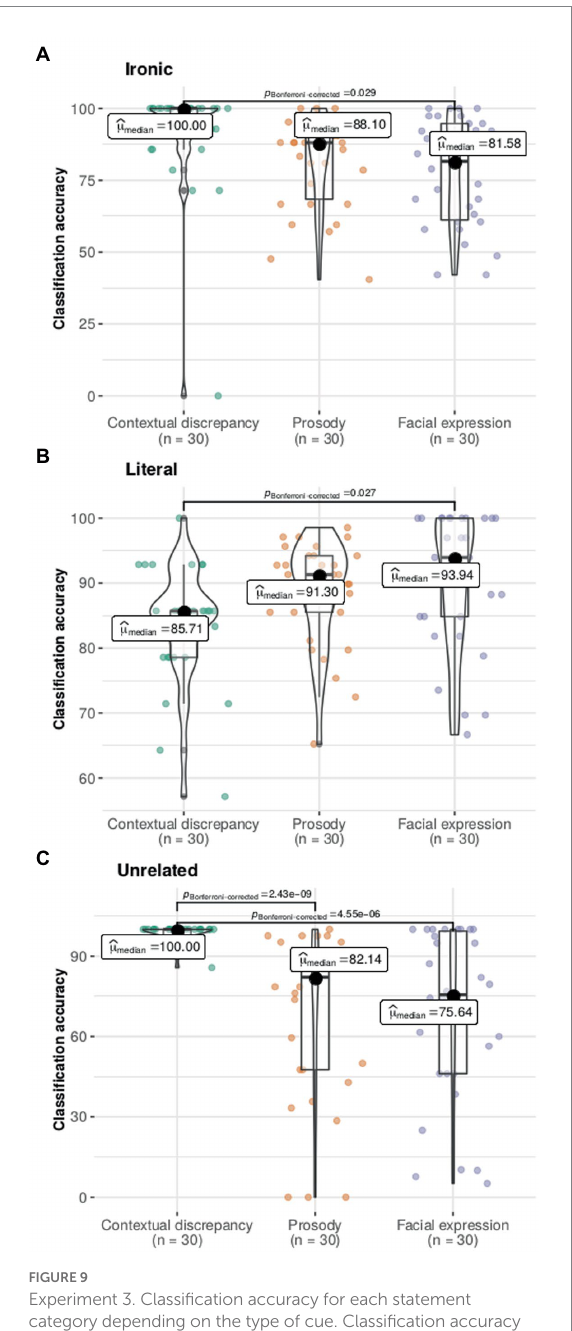
FIGURE 9 Experiment 3. Classification accuracy for each statement category depending on the type of cue. Classification accuracy represents the percentage of participants that classified each item accurately. The contextual discrepancy resulted in significantly greater classification accuracy for ironic (Panel (A) ) and unrelated statements (Panel (C) ) whereas for literal statements (Panel B) facial expression led to greater accuracy. Plots show the density curves and the box plots show the median (dark circle), mean (thick line), interquartile range (rectangle), and the lower/upper adjacent values (black lines stretched from the rectangle), and scatter plot. Significant differences between cues are